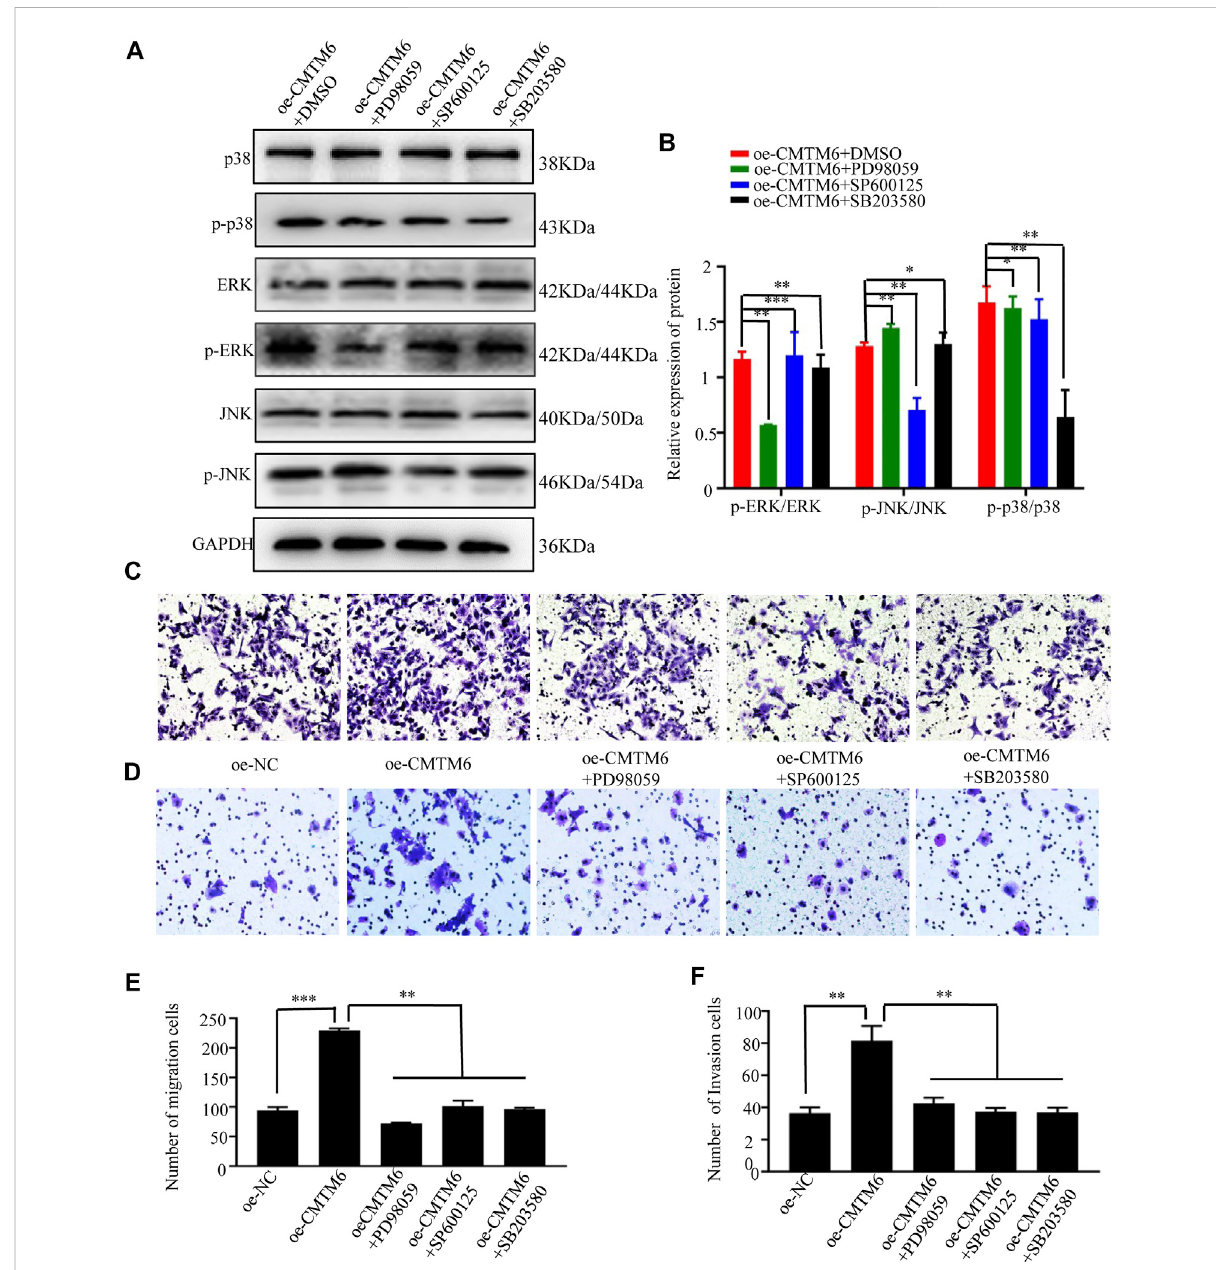
FIGURE 6 Effect of inhibitedMAPK signaling on CMTM6-regulated cell invasion and migration. (A,B) Western blotting showing the levels of MAPK-related proteins in each group. Data were normalized to the level of GAPDH. (C – F) Cell metastasis and migration were assessed using Transwell assays in which CMTM6 acted as an inhibitor of the MAPK signaling pathway. * p < 0.05; ** p < 0.01; *** p <